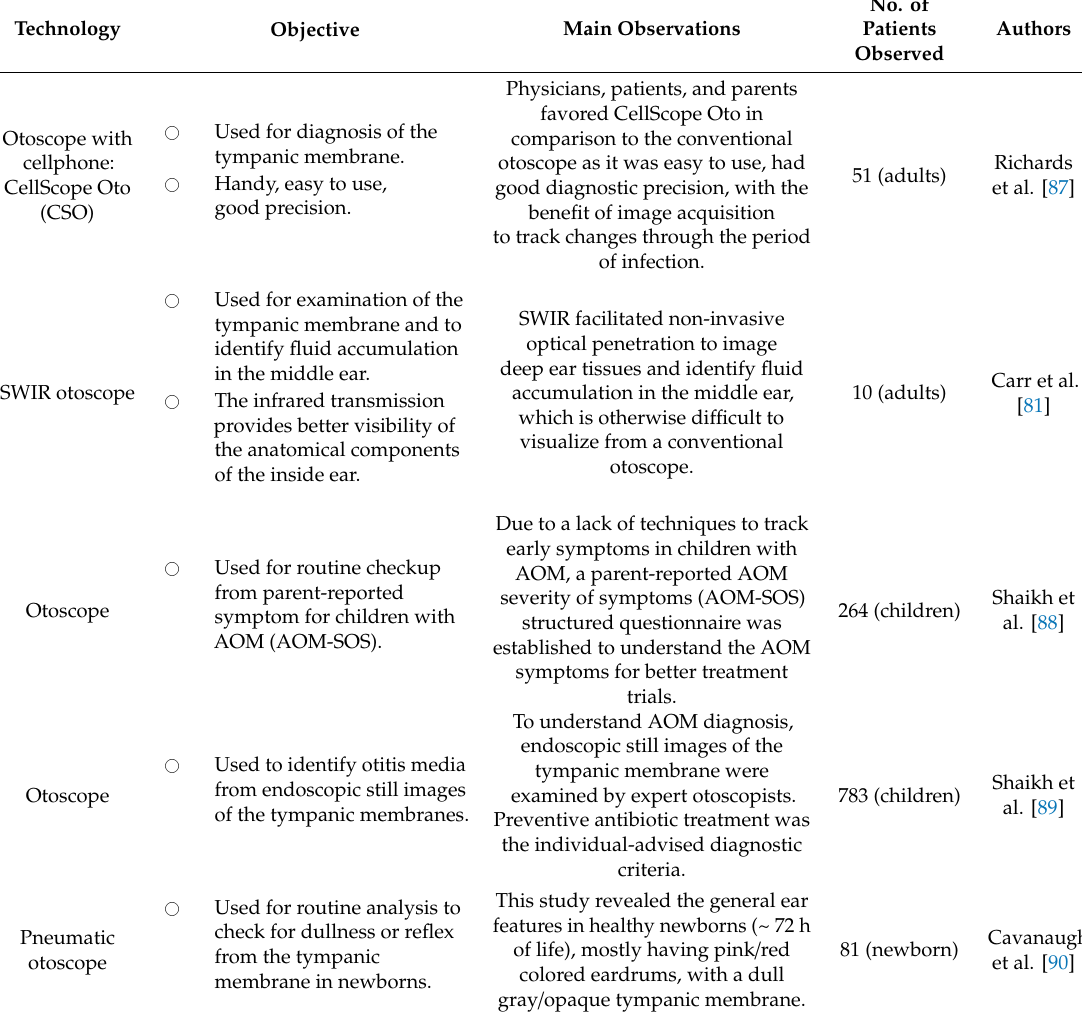
Table 3. List of Phase II clinical trials for ear infection